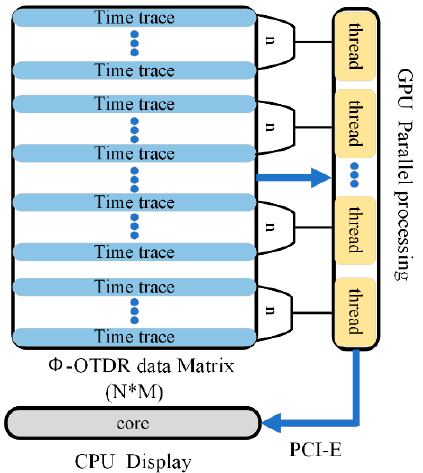
Figure 10. Cooperative data processing with GPU and CPU.